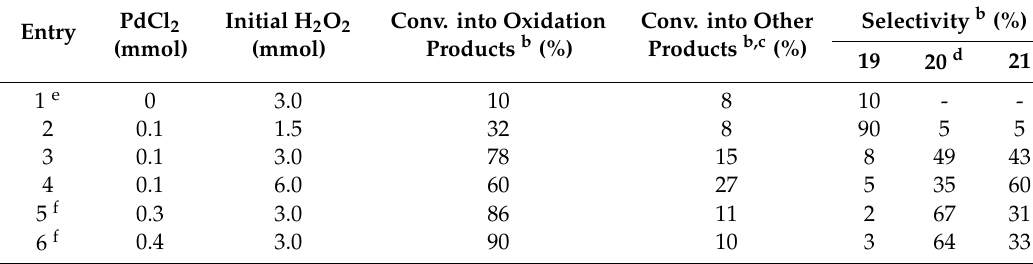
by GC analyses. c Complex mixture of products resulting from hydration of the olefinic bond, the skeletal rearrangement (hydroxycamphene, borneol, tricyclene). d 20 determined as two